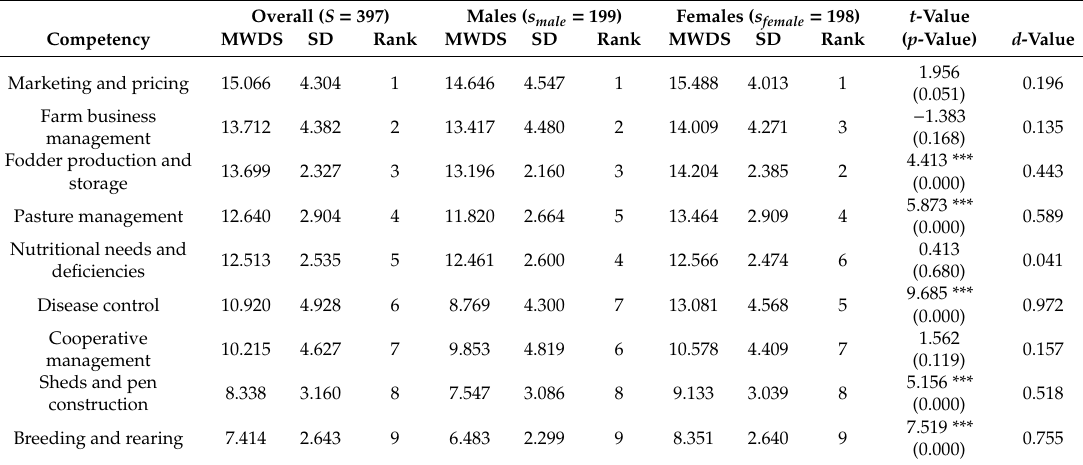
Table 5. Mean weighted discrepancy scores among beef cattle farmers. Overall ( S = 397) Males ( s male = 199) Females ( s female = 198) t -Value Competency MWDS SD Rank MWDS SD